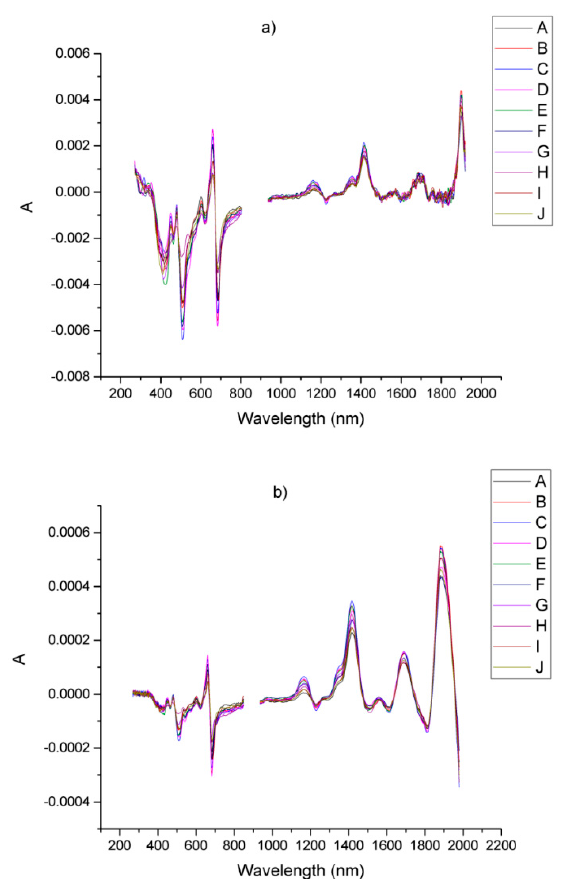
Figure 5. First derivative spectra of Arnicae flos, obtained from the curves from Figure 2b by using: ( a ) GS (Golay-Savitzky); ( b ) SBSF (Step-by-Step filter). The samples are defined in Table 1.